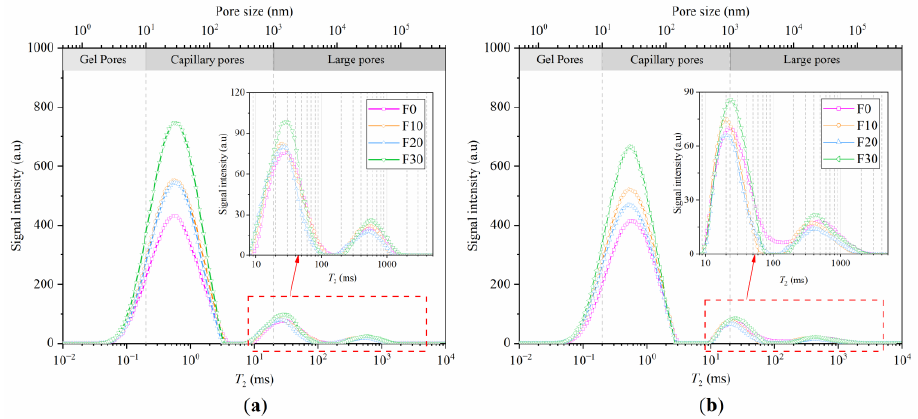
Figure 11. T 2 spectrum distribution curves of concrete with different FA contents. ( a ) At 28 days, ( b ) At 90 days.